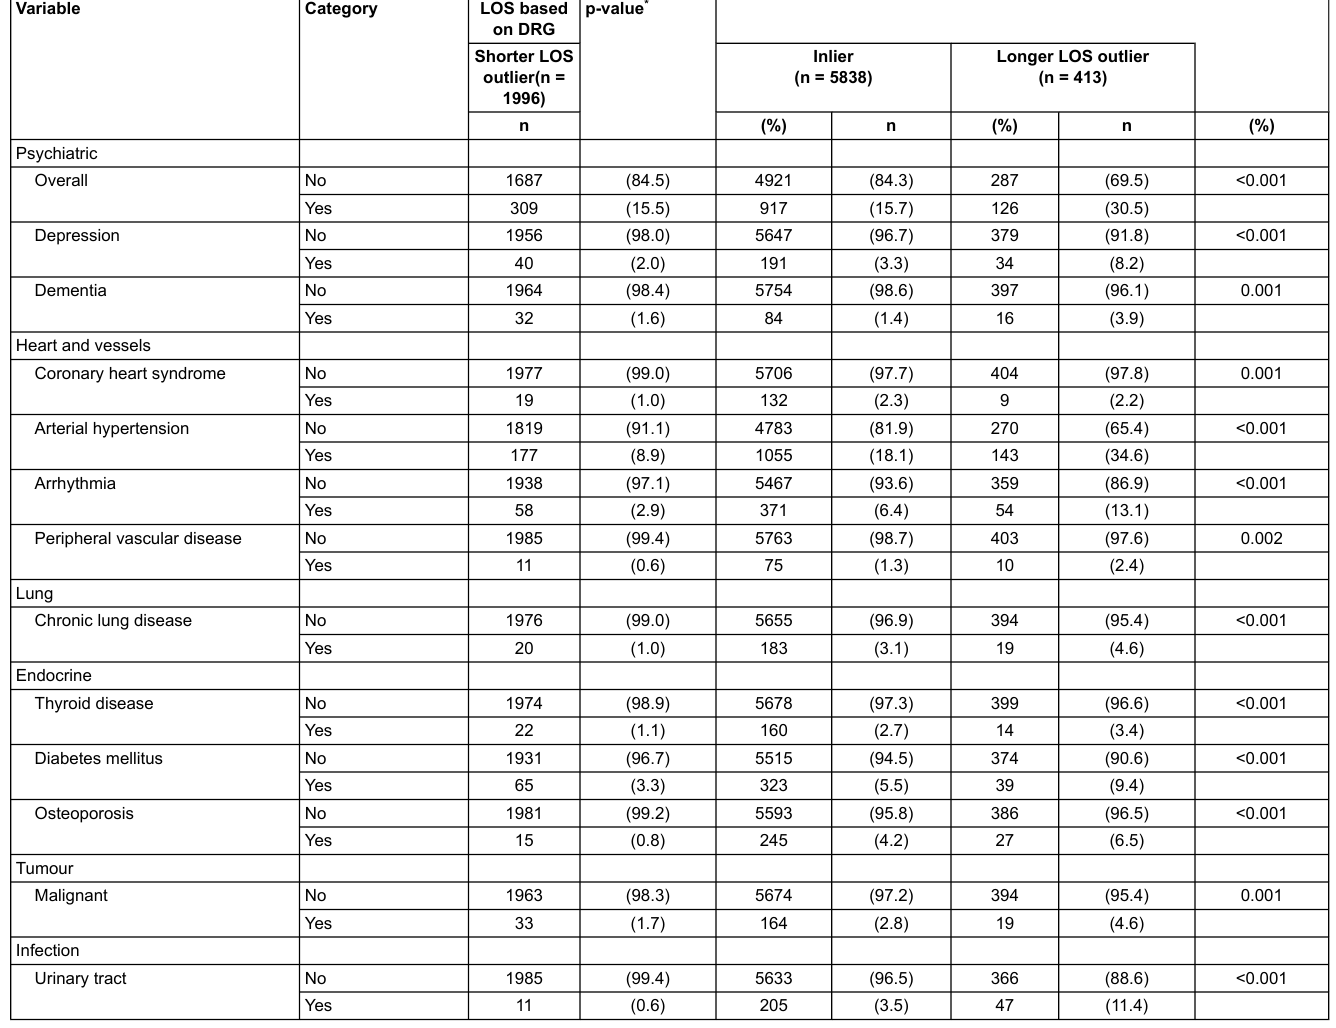
Table 4: Concomitant diseases according to the length of hospital stay (LOS) based on diagnosis related group (DRG) (n = 8247).